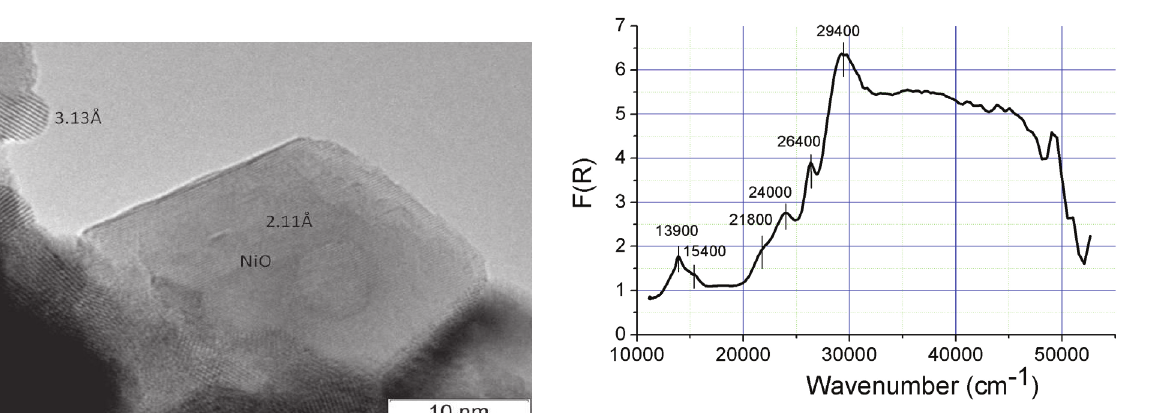
Figure 8: Typical high resolution TEM image of separate NiO nanoparticle in 5Ni/Ce